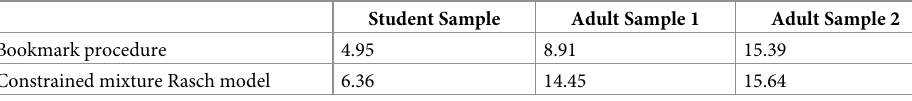
Table 3. Percentage of individuals within the low-literacy